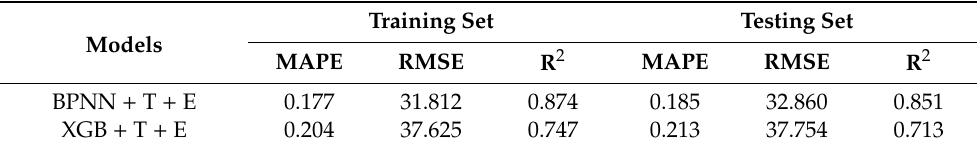
Figure 9. The taxi demand prediction based on “BPNN + T + E” and “XGB + T + E”. ( a ) Result of taxi demand prediction based on “BPNN + T + E”; ( b ) Result of taxi demand prediction based on “XGB + T + E”. Table 9. Prediction effects of taxi demand prediction based on BPNN and XGB.